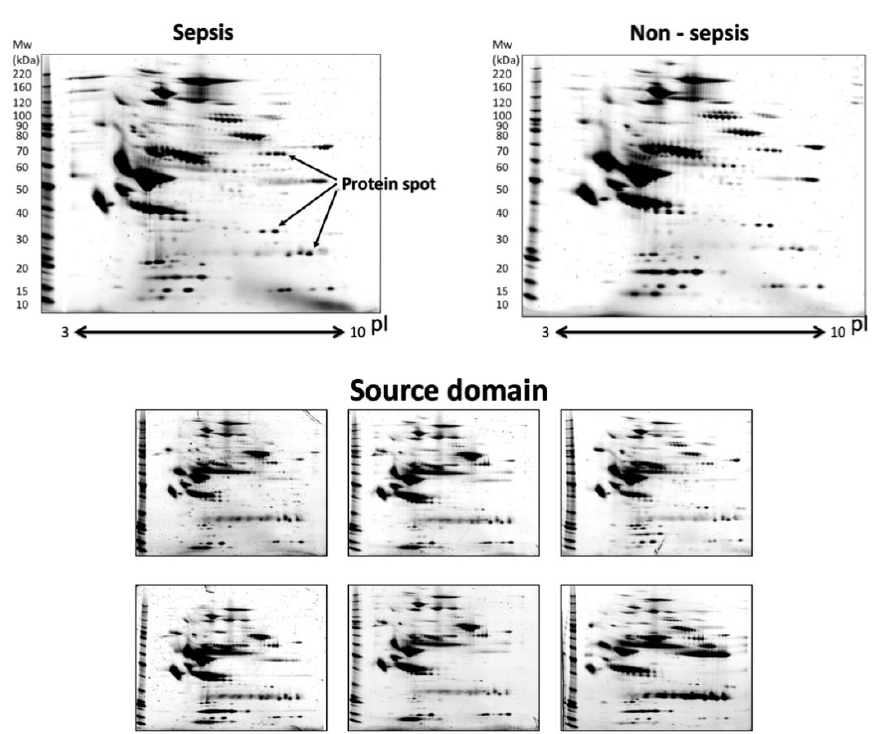
Figure 3. Examples of two-dimensional gel electrophoresis (2D-GE) images. X and Y-axes represent isoelectric points (pI) and molecular weights (Da), and black regions represent protein spots. Upper left: sepsis. Upper right: non-sepsis. Lower: source domain 2D-GE images. The position of the same protein is approximately the same for each patient because each axis represents an absolute physical quantity. Our previously developing technology has incremented the accuracy 1 . However, as shown in this figure, it is difficult for even an expert to detect valid spots for classifying sepsis. Thus, we directly inputted 2D-GE images in the